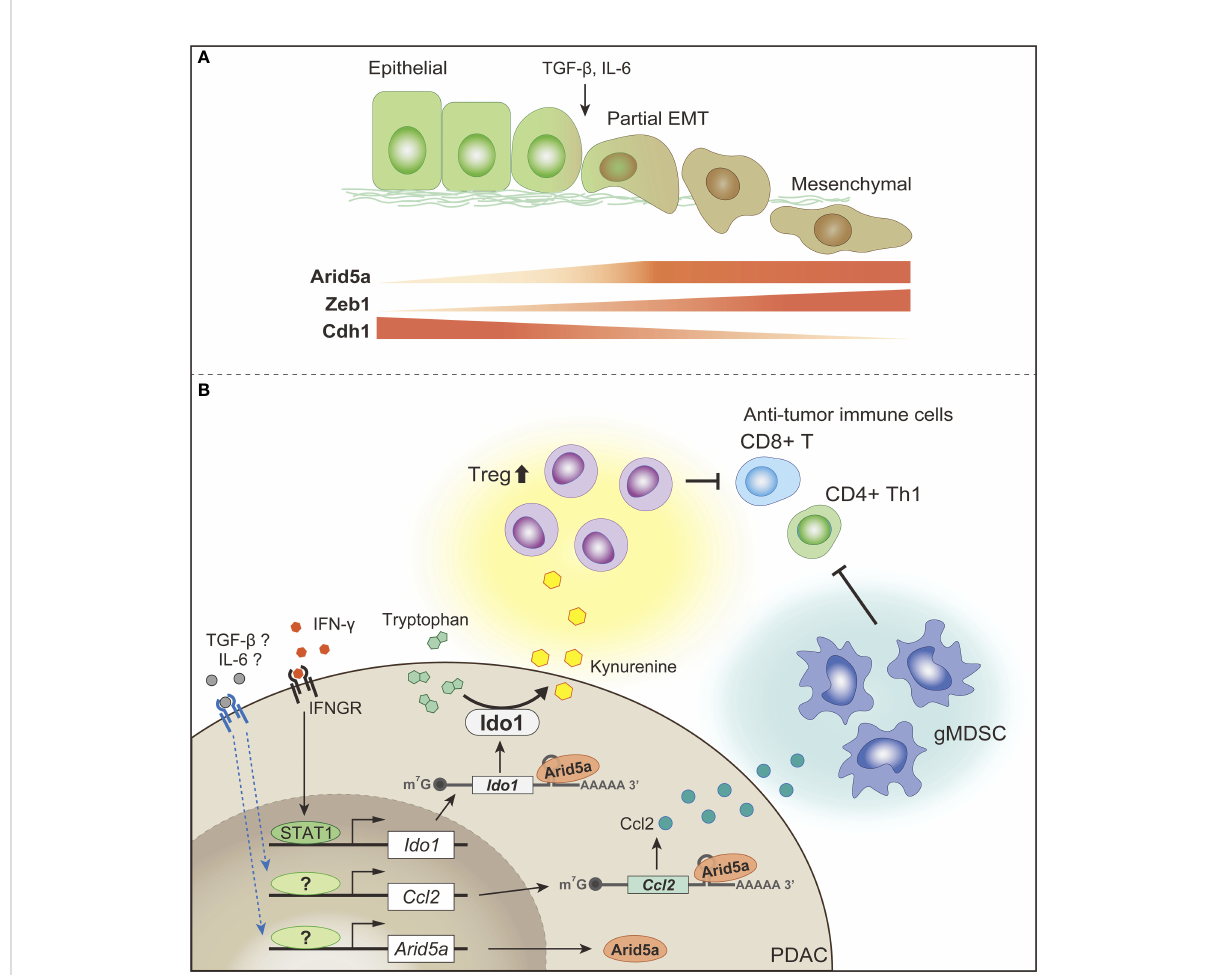
FIGURE 4 Involvement of Arid5a in the acquisition of mesenchymal plasticity and immune evasiveness in PDAC (A) Arid5a expression is associated with acquisition of the mesenchymal phenotypes of PDAC and CRC. Especially, cells showing partial EMT and mesenchymal-like cell lines show much higher expression levels of ARID5A than epithelial-like cell lines. During TGF- b - or IL-6-induced EMT, Arid5a level is augmented in cells that have acquired mesenchymal phenotypes. (B) Arid5a acts as a dual regulator in malignant tumors, such as the mesenchymal subtypes of PDAC, to promote an immunosuppressive TME; Arid5a upregulates Ido1 expression via post-transcriptional stabilization of its mRNA and then enhances the suppressive effects of Ido1 on anti-tumor immune cells, such as CD8 + T cells and CD4 + Th1 cells via a reduction in intratumoral tryptophan concentration, and a promotion of the differentiation and activation of Treg cells. Additionally, Arid5a post-transcriptionally induces the expression of the chemokine Ccl2 in the TME, which recruits immunosuppressive cells, such as Treg cells and gMDSCs, to the